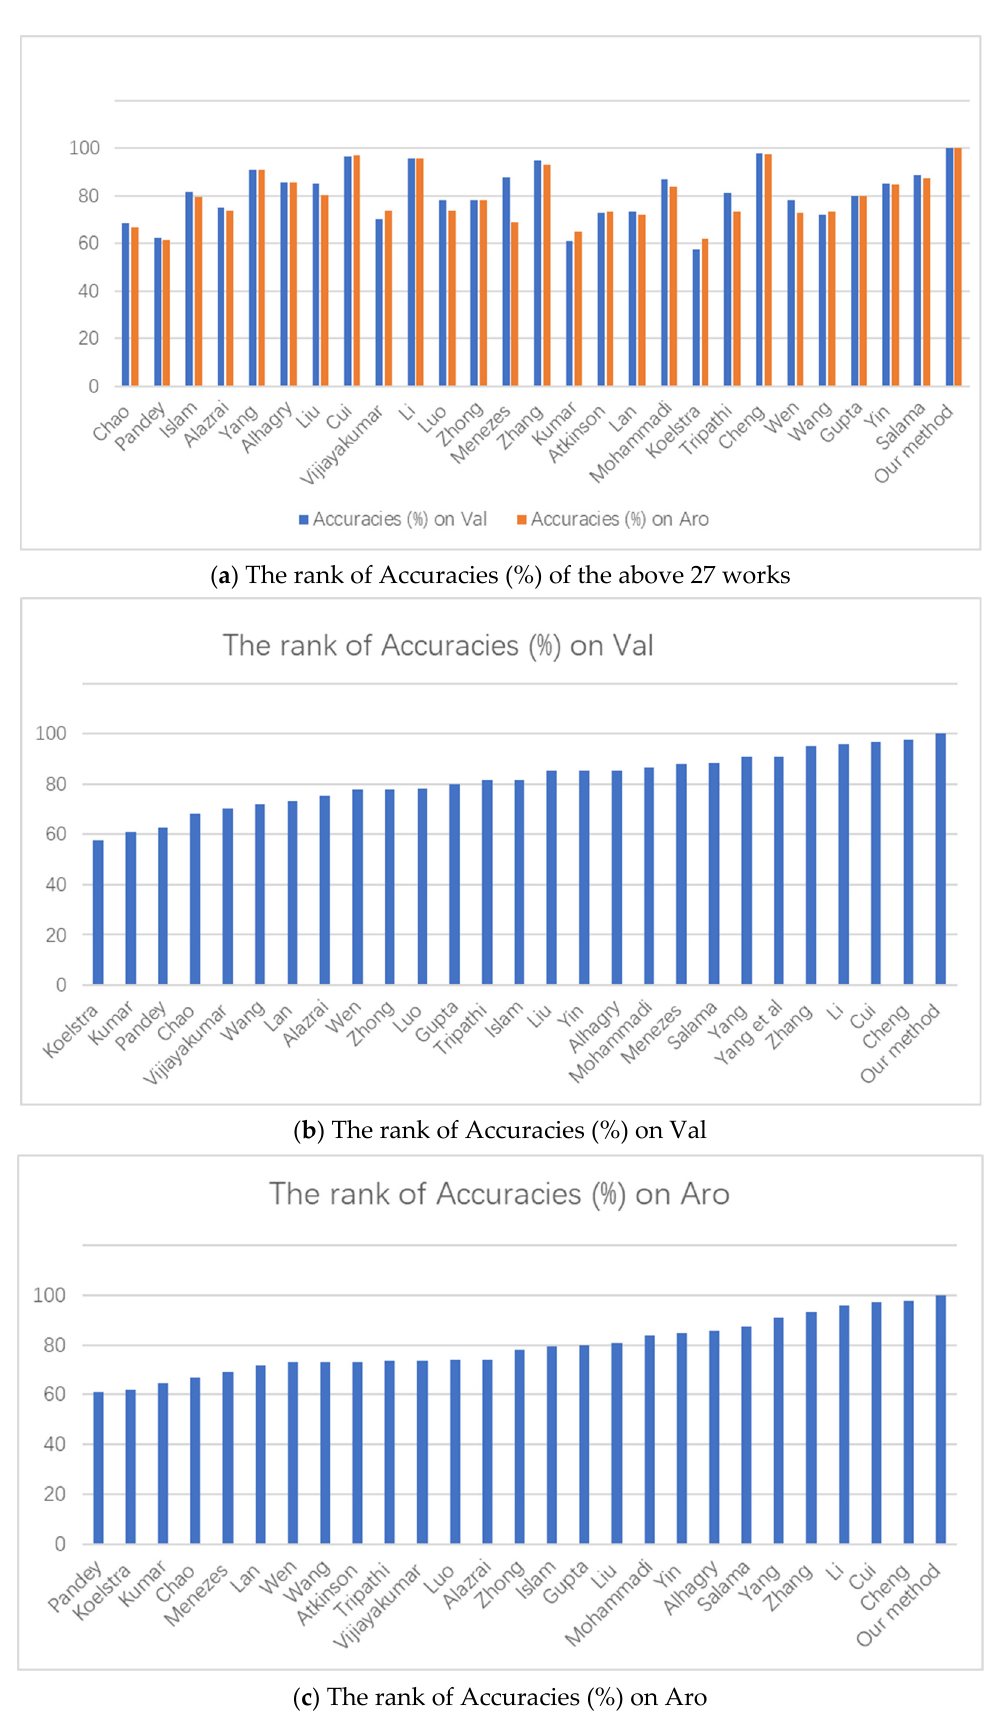
Figure 12. ( a-c ) Comparison in the form of histograms. Figure 12. ( a – c ) Comparison in the form of